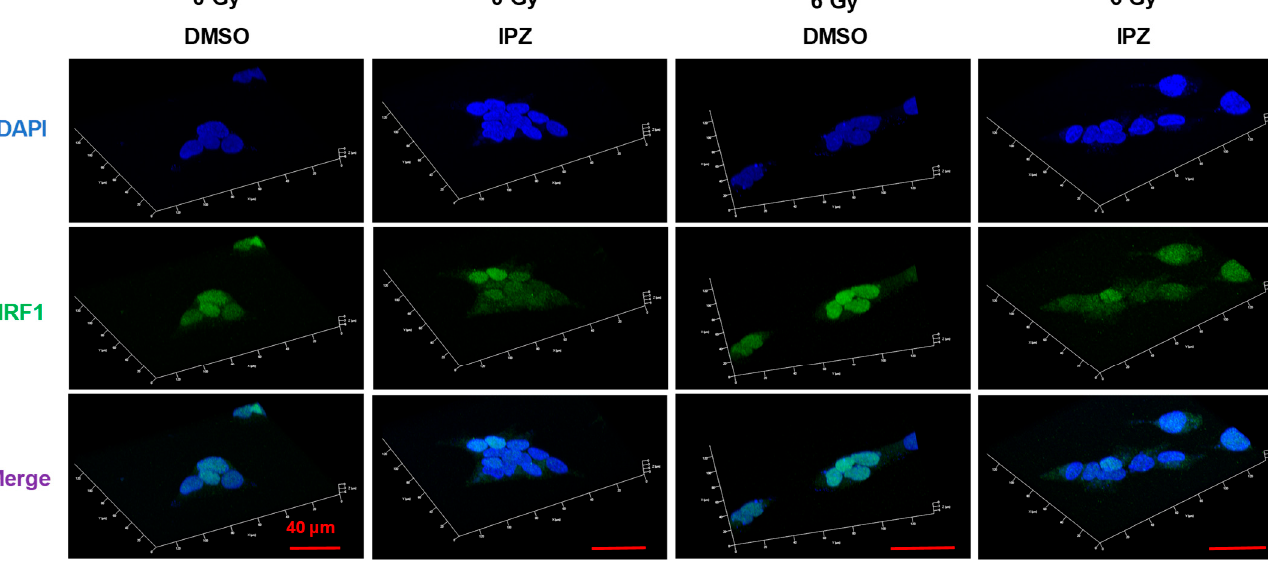
Figure 3. Effects of IPZ on the localization of IRF1 in Ca9-22 cells. IPZ (10 μ M) was added to the culture medium at 1 h before irradiation at 6 Gy. After 24 h of culture, the treated Ca9-22 cells were harvested for the analysis of confocal images of IRF1. A 3D constructed image with maximum intensity is shown. Scale bar, 40 μ m.